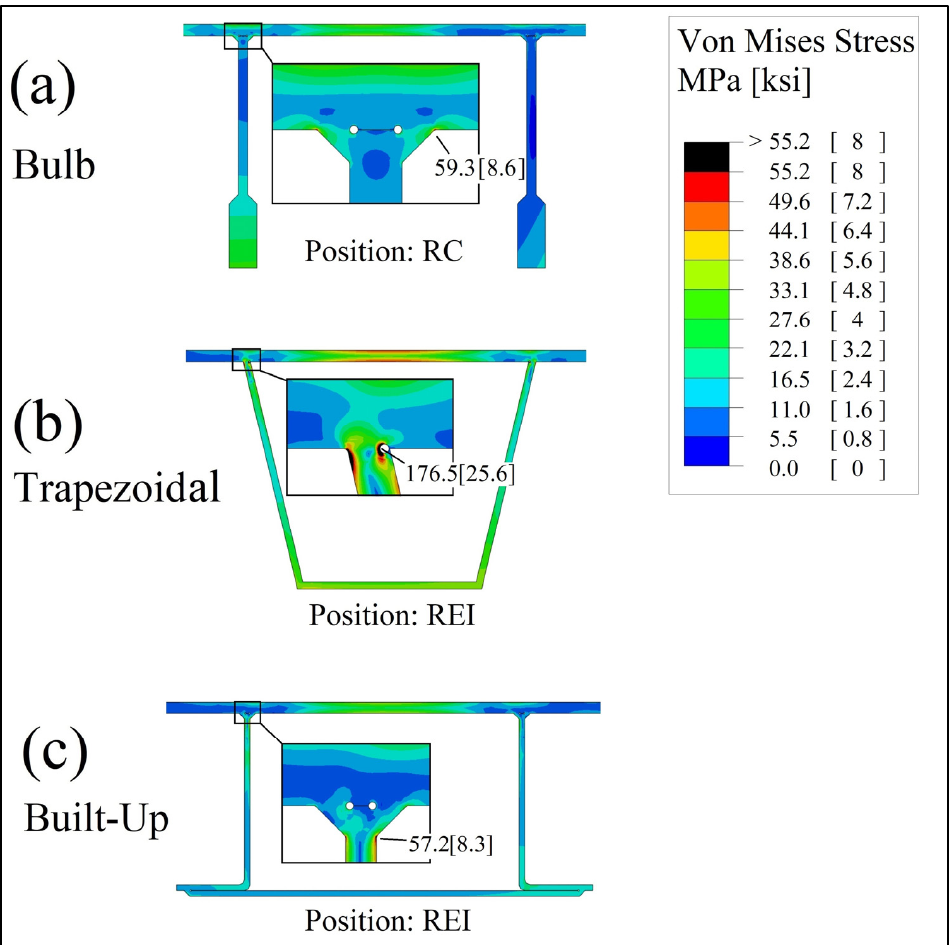
Figure 17. Von Mises stress distribution under the rear wheel load in continuum case 1.